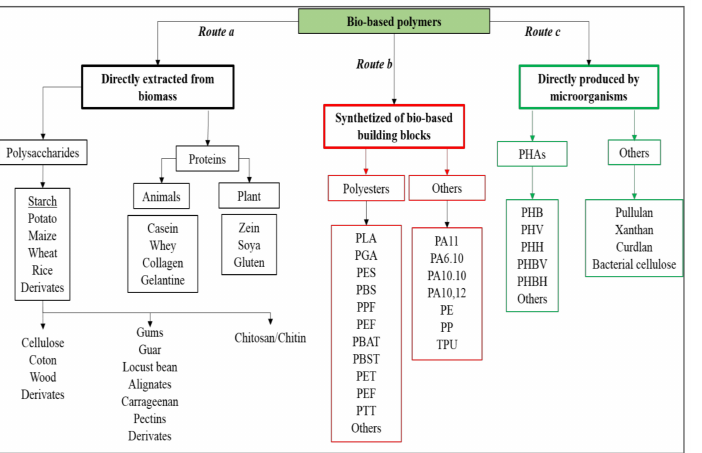
Figure 2. Bio-based polymers classification: (a) directly extracted from biomass, (b) obtained through polymerization of bio-based building blocks, and (c) directly produced by microorganisms. PLA = poly(lactic acid); PGA = poly(glycolic acid); PES = poly(sulfone)s; PBS = poly(butylene succi- nate); PPF = poly(propylene 2,5-furandicarboxylate); PEF = poly(ethylene 2,5-furandicarboxylate); PBAT = poly(butylene adipate-co-terephthalate); PBST = poly(butylene succinate-co-terephthalate); PET = poly(ethylene terephthalate); PTT = Poly(trimethylene terephthalate); PA11 = polyamide 11; PA6.10 = polyamide 6.10; PA10.10 = polyamide 10.10; PA10.12 = polyamide 10.12; PE = polyethylene; PP = polypropylene; TPU = thermoplastic polyurethane; PHB = poly(3-hydroxybutyrate); PHV = poly(3-hydroxyvalerate); PHH = poly(3-hydroxyhexanoate); PHBV = poly(3-hydroxybutyrate- co -3- hydroxyvalerate); PHBH = poly(3-hydroxybutyrate- co